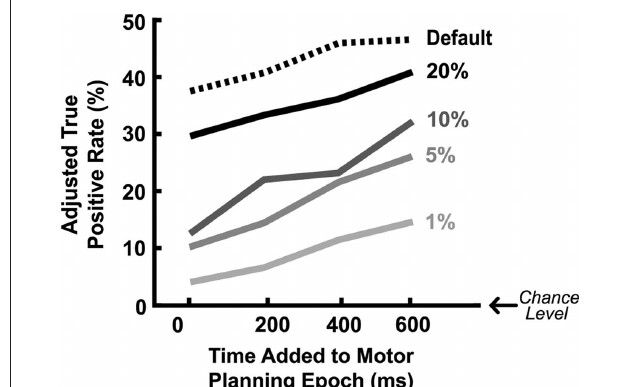
Figure 3 | Mean adjusted true-positive rate as a function of the assumed duration of the motor-planning phase used for training/ assessing the classifiers. Different lines indicate results when different threshold settings are used to generate the predefined false-positive rates shown. The false-positive rates have already been subtracted out from the actual true-positive rates to get the adjusted true-positive rates plotted